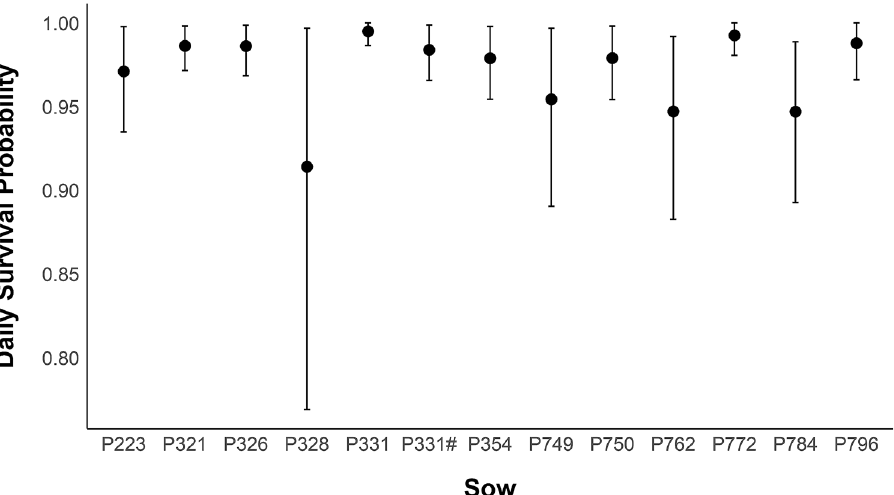
Figure 2. Average daily survival probability of neonate wild pigs. Daily wild pig ( Sus scrofa ) neonate survival probability with 95% CI for each sow on the Savannah River Site, Aiken Allendale, and Barnwell counties, SC, USA from 2017 to 2020. Values are calculated from the null model with sow as a random effect. Note, sow P331 gave birth three times during the study and neonates from two litters were monitored for survival.